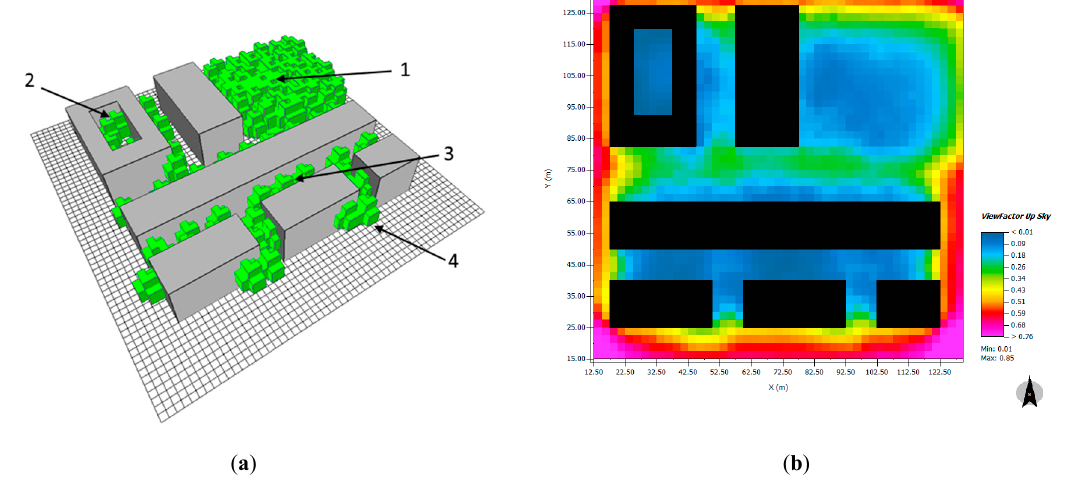
Figure 2. ( a ) Model domain for the microclimatic scenarios: (1) Park, (2) Courtyard, (3) Urban Canyon, and (4) Suburban; and ( b ) calculated sky view factor for different grid cells.